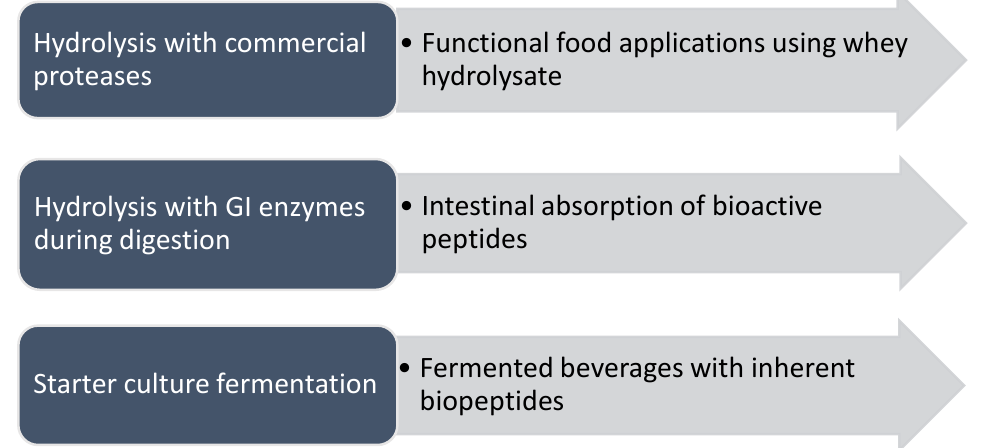
Figure 3. Production methods of bioactive peptides derived from whey proteins and their utilization potential.